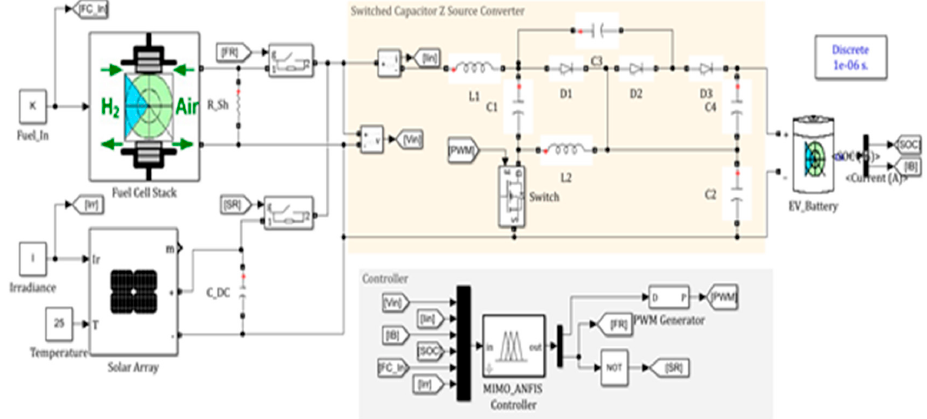
Figure 41. Overall simulation figure.